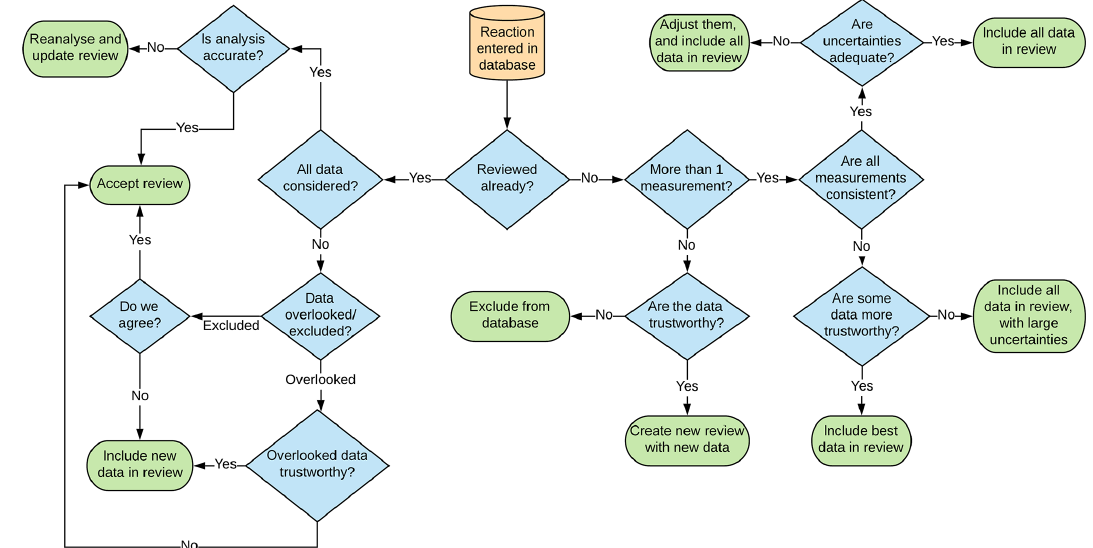
Figure 3. Decision tree describing the data review process for our